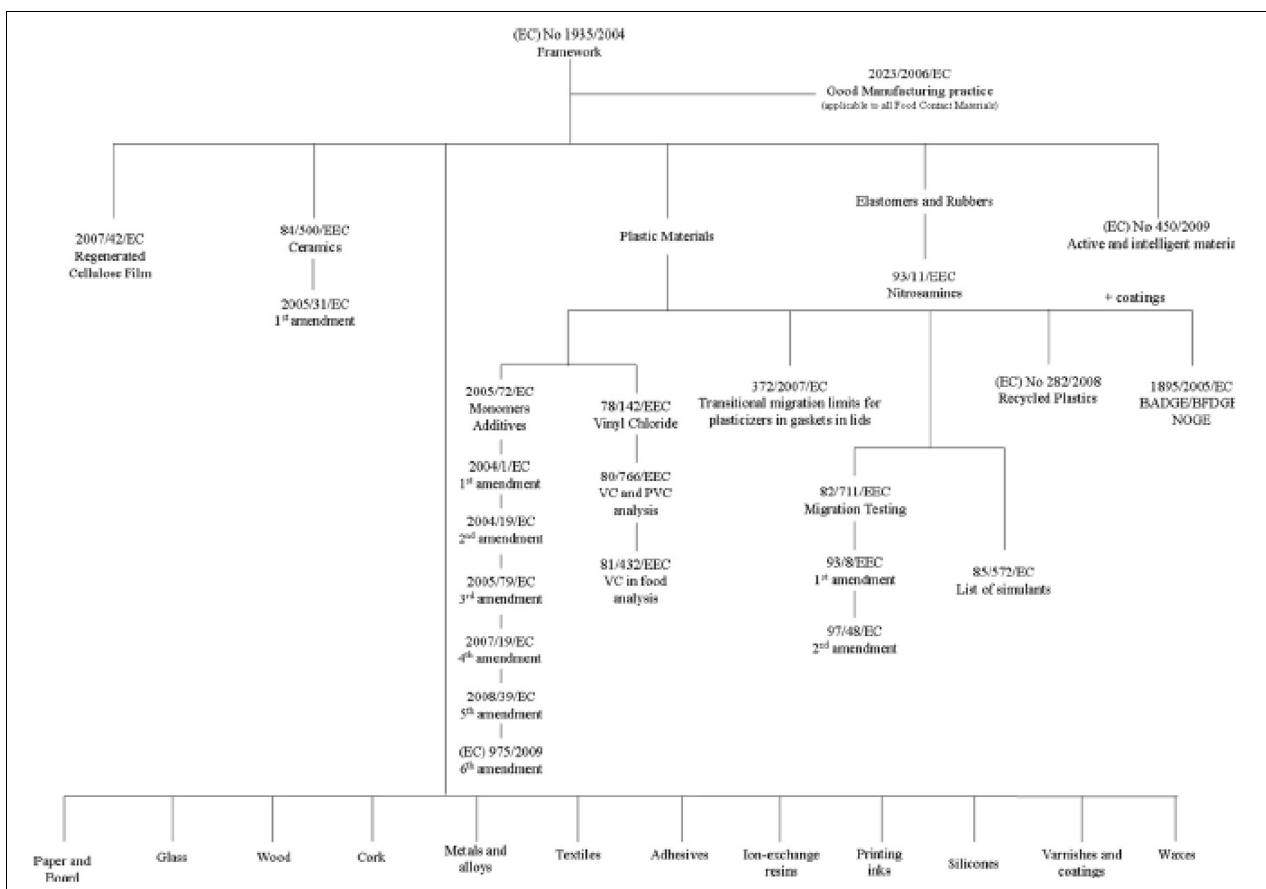
FIGURE 3 | EU food-contact materials legislation (Restuccia et al., 2010) (with